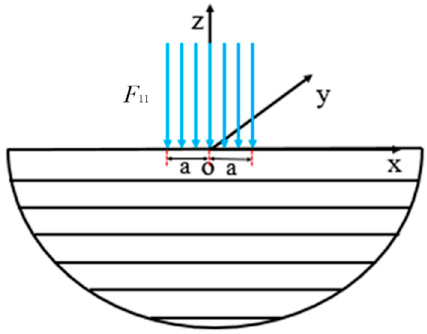
Figure 3. Transversely isotropic elastic half ‐ plane surface subjected to vertically distributed stress.